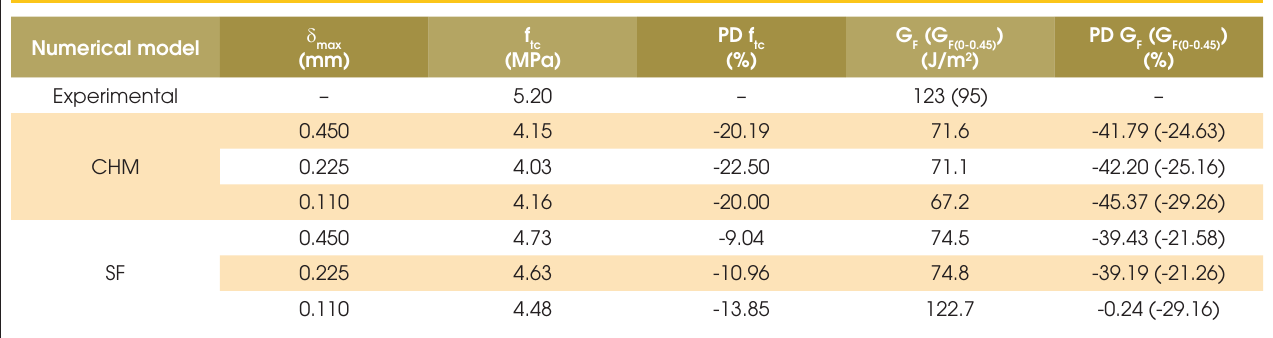
Table 9 – Comparison of the results of the simultaneous fit by Bilinear